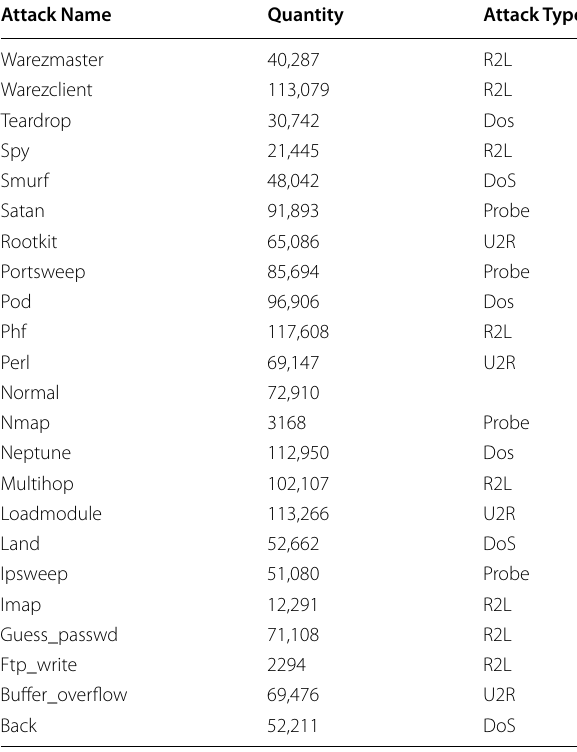
Table 2 Dataset data